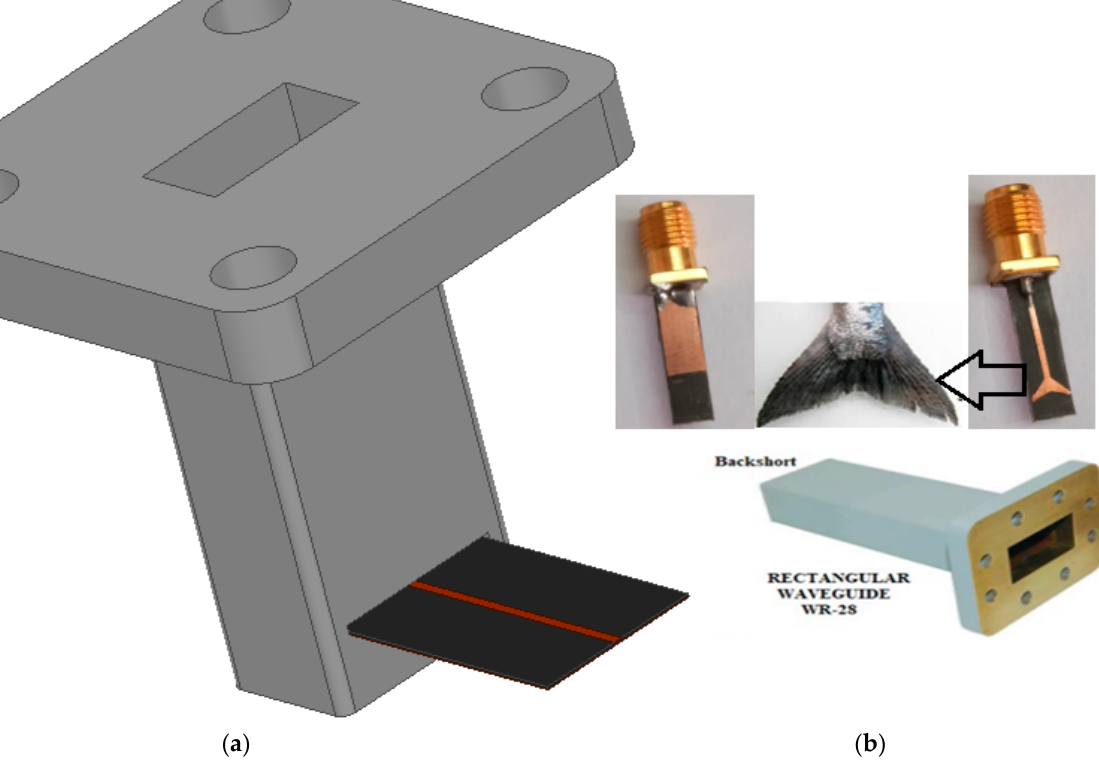
Figure 9. ( a ) Ka-band RWG-to-MSL transition model, ( b ) prototype of the nature-inspired fish-tail microstrip line.